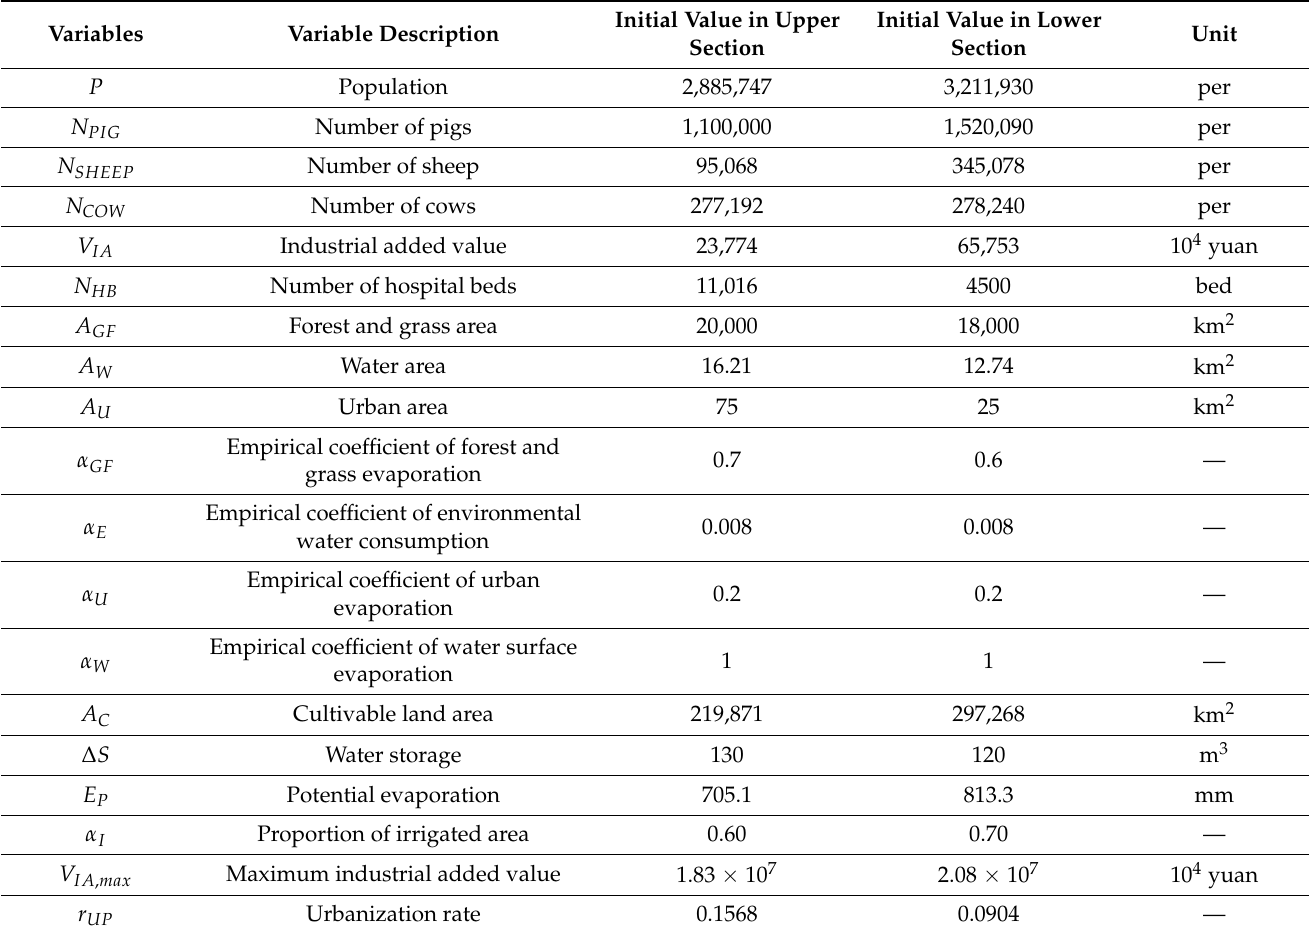
Table 2. The initial values of the main variables and calibrated parameters of the evolution model. Initial Value in Upper Initial Value in Variable Description